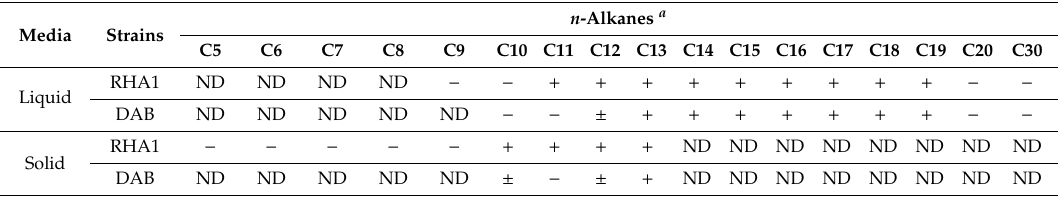
Table 3. Growth of R. jostii RHA1 and DAB on n